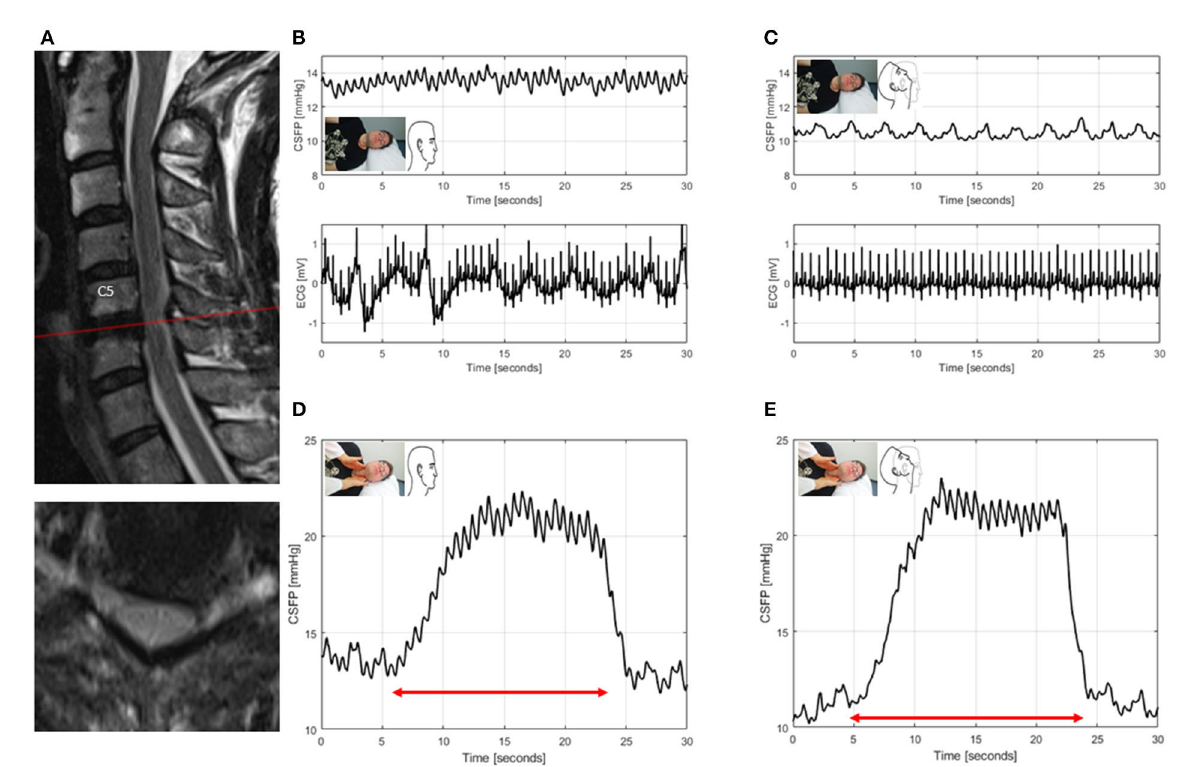
FIGURE5 T2-weighted MRI of the cervical spine for ID4 (patient with spinal canal stenosis of unknown significance, previously underwent surgery for degenerative cervical myelopathy, mJOA: 13) (A) . Sagittal and axial images show posterior cord compression at levels C5/6. CSFP and electrocardiogram (ECG) are shown during resting state in neutral head position with baseline CSFP of 13.5 mmHg and cardiac-driven CSFP peak-to-trough amplitude (CSFPp) of 0.7 mmHg (B) , and, in head reclination, baseline CSFP and CSFPp both declined to 10.5 mmHg and 0.3 mmHg, respectively (C) . CSFP during the Queckenstedt’s test in neutral head position (rise, 9. mmHg) (D) , and, in head reclination, (rise, 10.5 mmHg) (E)